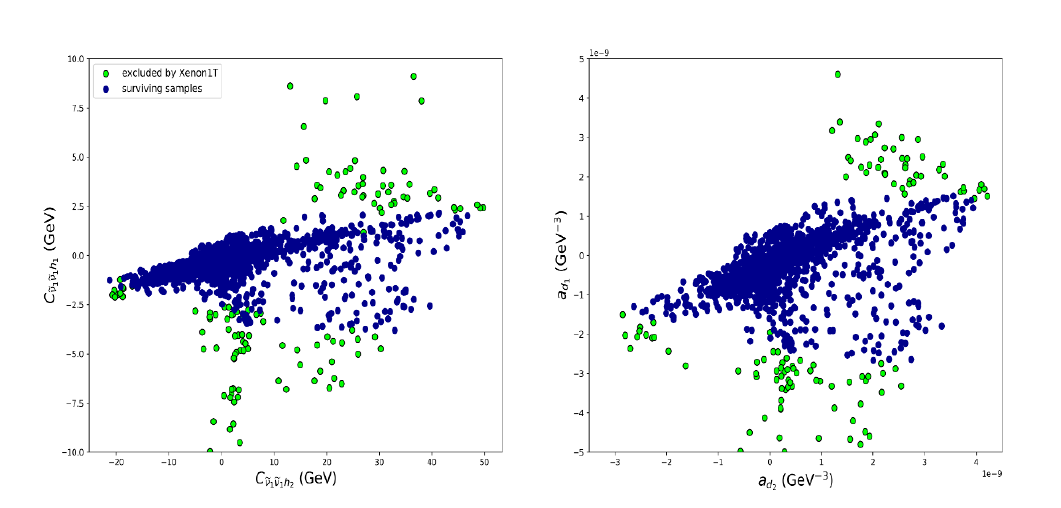
Figure 4 . Same samples as those in the left panel of (cid:12)gure 3, but projected on the C ~ (cid:23) plane (left panel) and the a d (cid:0) a d plane (right panel). These samples are classi(cid:12)ed by whether 1 2 they are excluded by the XENON-1T experiment (marked by green color) or not (dark blue color).